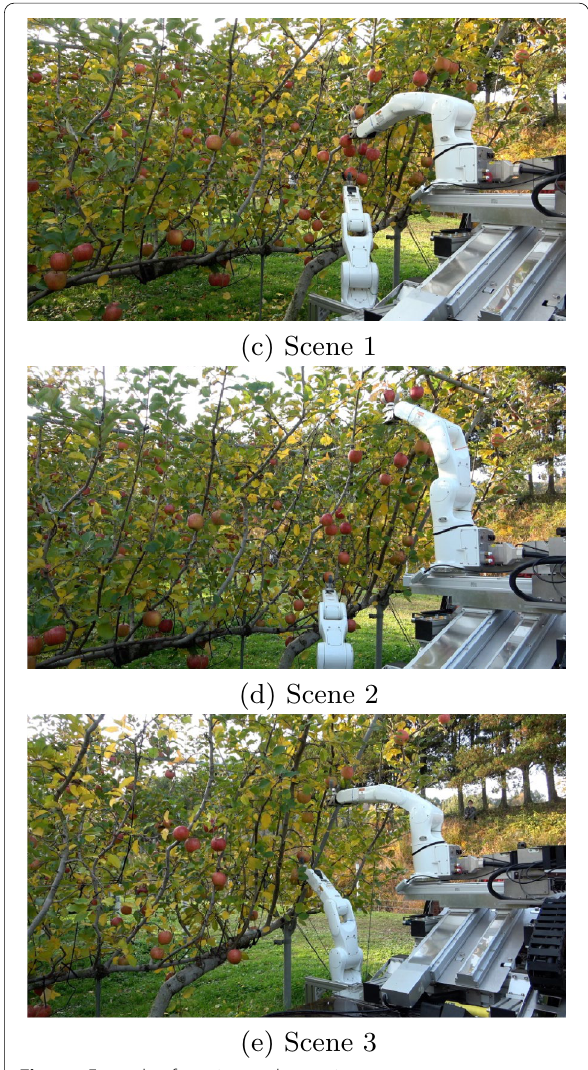
Fig. 17 shows an example of a harvesting robot mov- ing while harvesting. In this case, 23 out of 25 fruits were harvested. Conversely, the cause of the harvest failure was occlusion by leaves and branches. Excluding state transitions, the average time taken for recognition and harvesting was about 24 seconds. Jetson AGX Xavier from NVIDIA was used for the